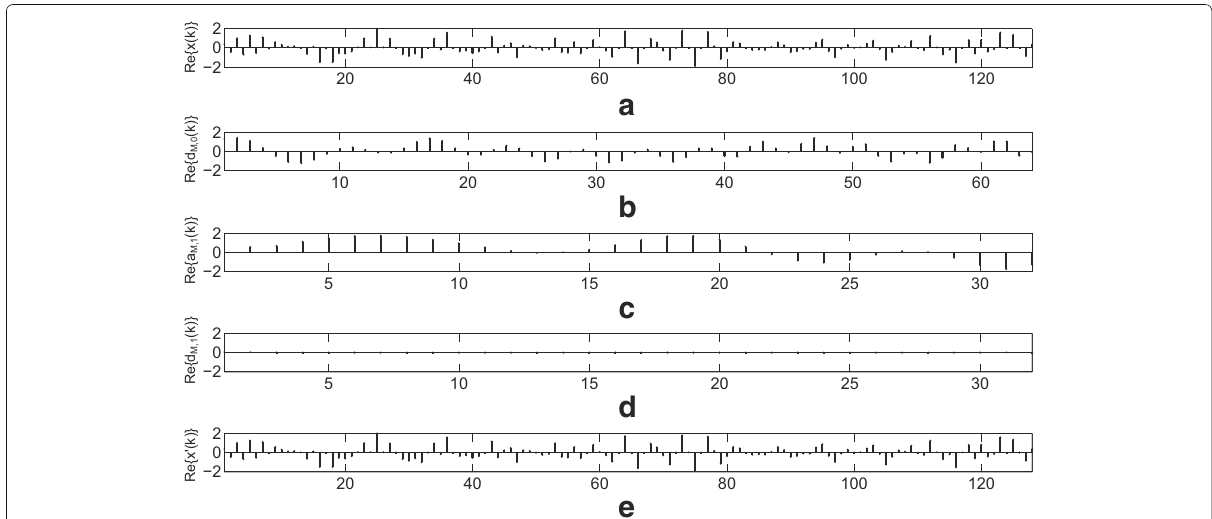
Fig. 5 Two-layer DLCWT of a signal x ( n ) computed using db3 wavelets. a Real part of original signal x ( k ) . b Real part of coefficients d M ,0 ( k ) . c Real part of coefficients a M ,1 ( k ) . d Real part of coefficients d M ,1 ( k ) . e Reconstructed signal x (cid:14) ( k